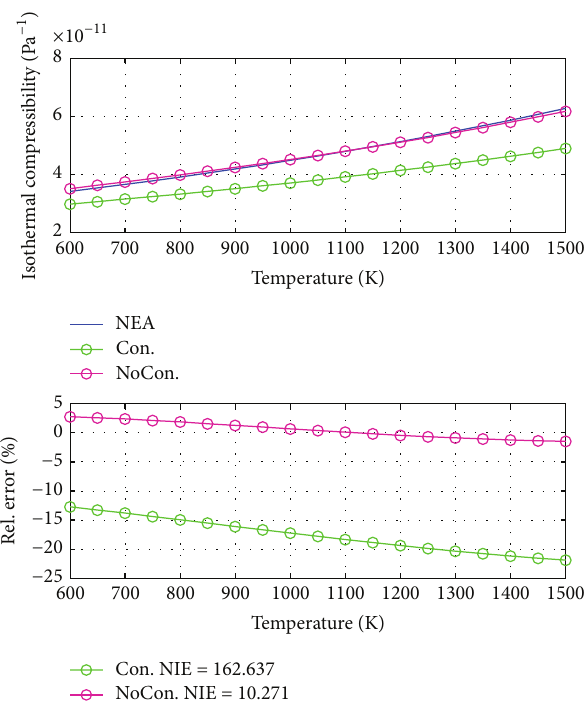
Figure 19: Lead isothermal compressibility, NEA data versus con- strained and nonconstrained optimization results.